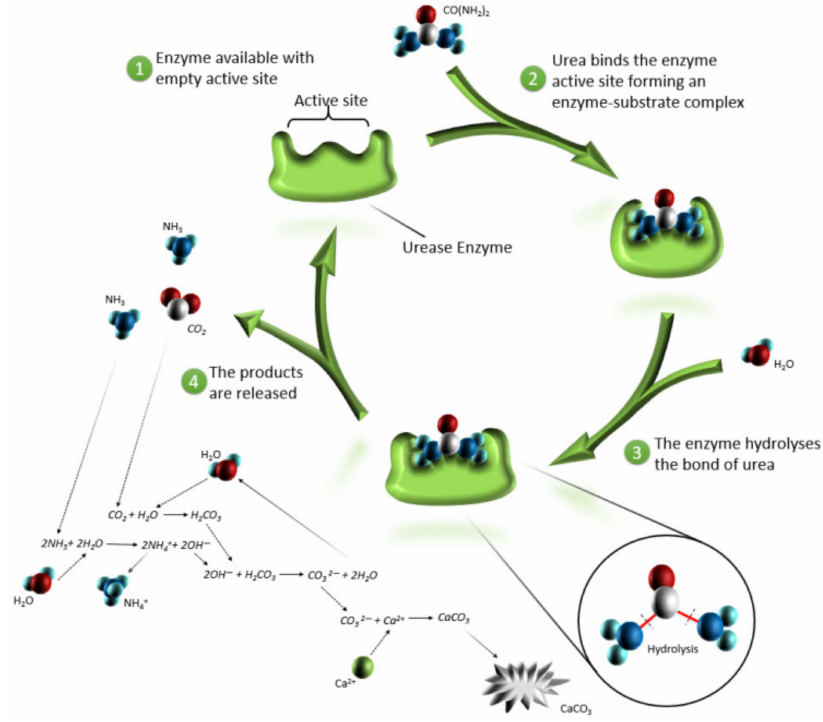
Figure 2. A representation of calcite precipitation due to the EICP method